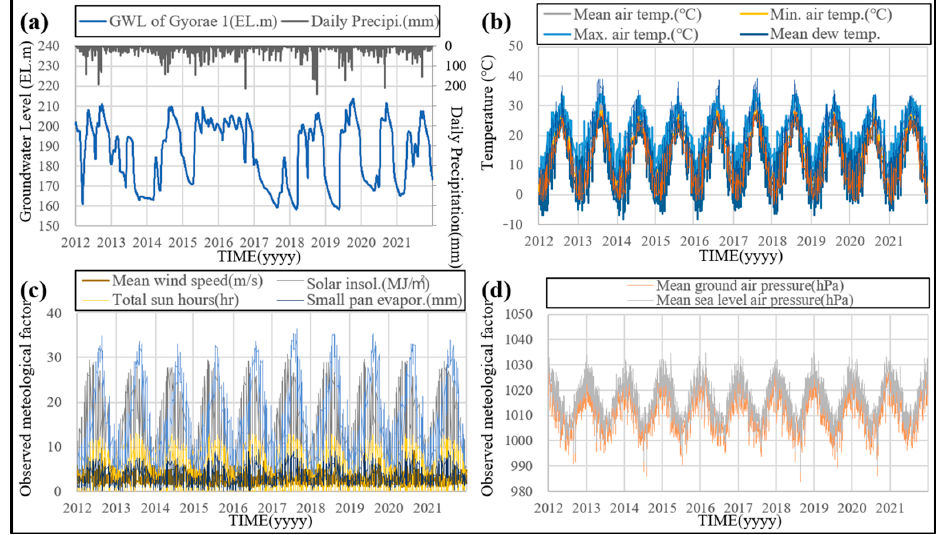
Figure 2. Obtained groundwater level and meteorological factors from 2012 to 2021: ( a ) groundwater level and daily precipitation; ( b ) daily mean, minimum and maximum air temperature and dew point temperature; ( c ) daily mean wind speed, Solar insolation, total sun hours and small pen evaporation; and ( d ) daily mean ground air and sea level air pressure.